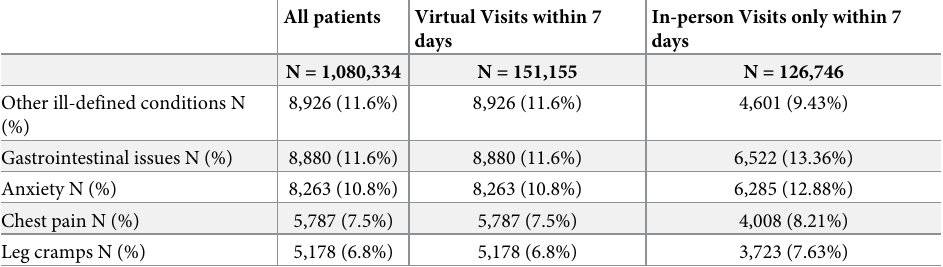
Table 4. Top 5 reasons for the last virtual visit prior to ED admission, N (%), July 1, 2021- September 30, 2021. All patients Virtual Visits within 7